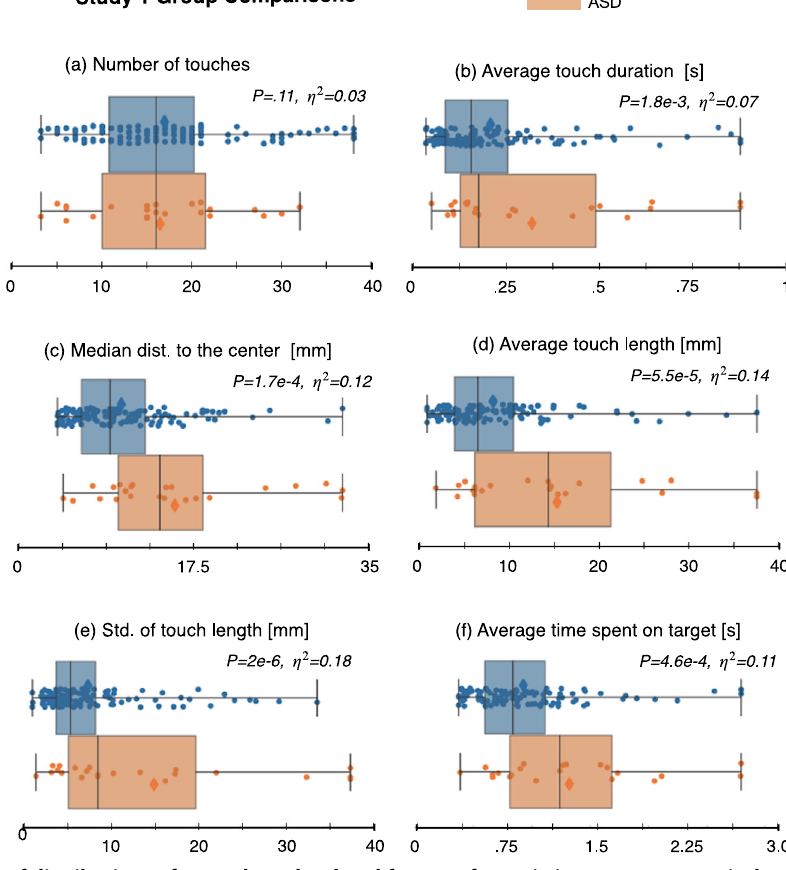
Fig. 2 Group comparisons of distributions of several touch-related features for autistic versus neurotypical participants in study 1. These motor-related features show statistically signi fi cant differences between the groups (except for the number of touches ). The extracted features presented here are detailed in the features extraction section. P -values were computed using a one-way ANCOVA, and corrected using Benjamini – Hochberg procedure to control for FDR. Effect sizes are denoted as η 2 . The line within the boxplot represents the median, the box represents the interquartile range, and the whiskers show extreme values. Scatter points show feature values for each